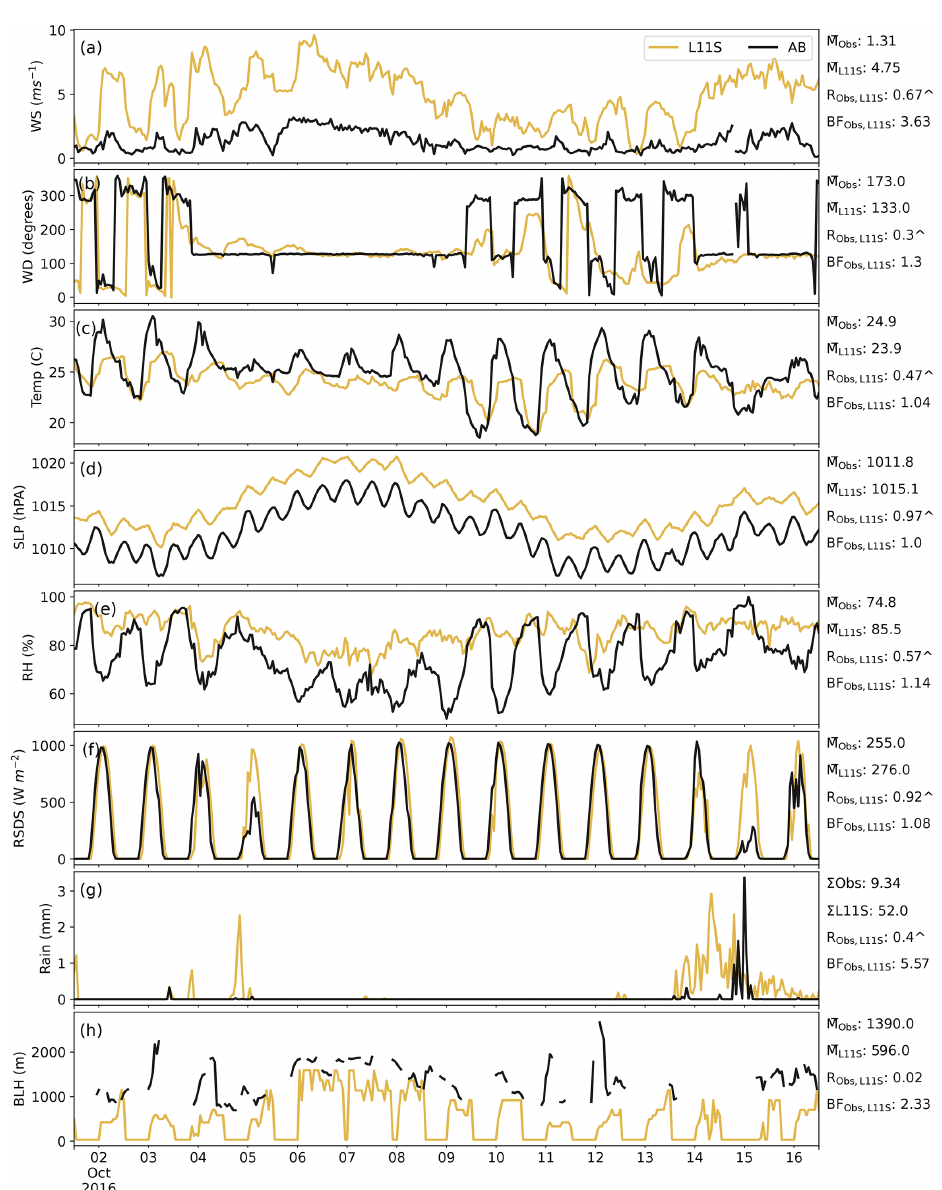
Figure C2. Time series for AIRBOX (in UTC) in descending order of wind speed, wind direction, temperature, sea level pressure, relative humidity, surface incoming radiation, rainfall and boundary layer height, comparing the L11S WRF simulation (yellow) to observations (black). Summary statistics are shown for the observations and L11S including the mean ( M ) (or sum (cid:54) ), the correlation ( R ) and the normalised mean bias factor. ∧ indicates where the R values are significant to the 95th